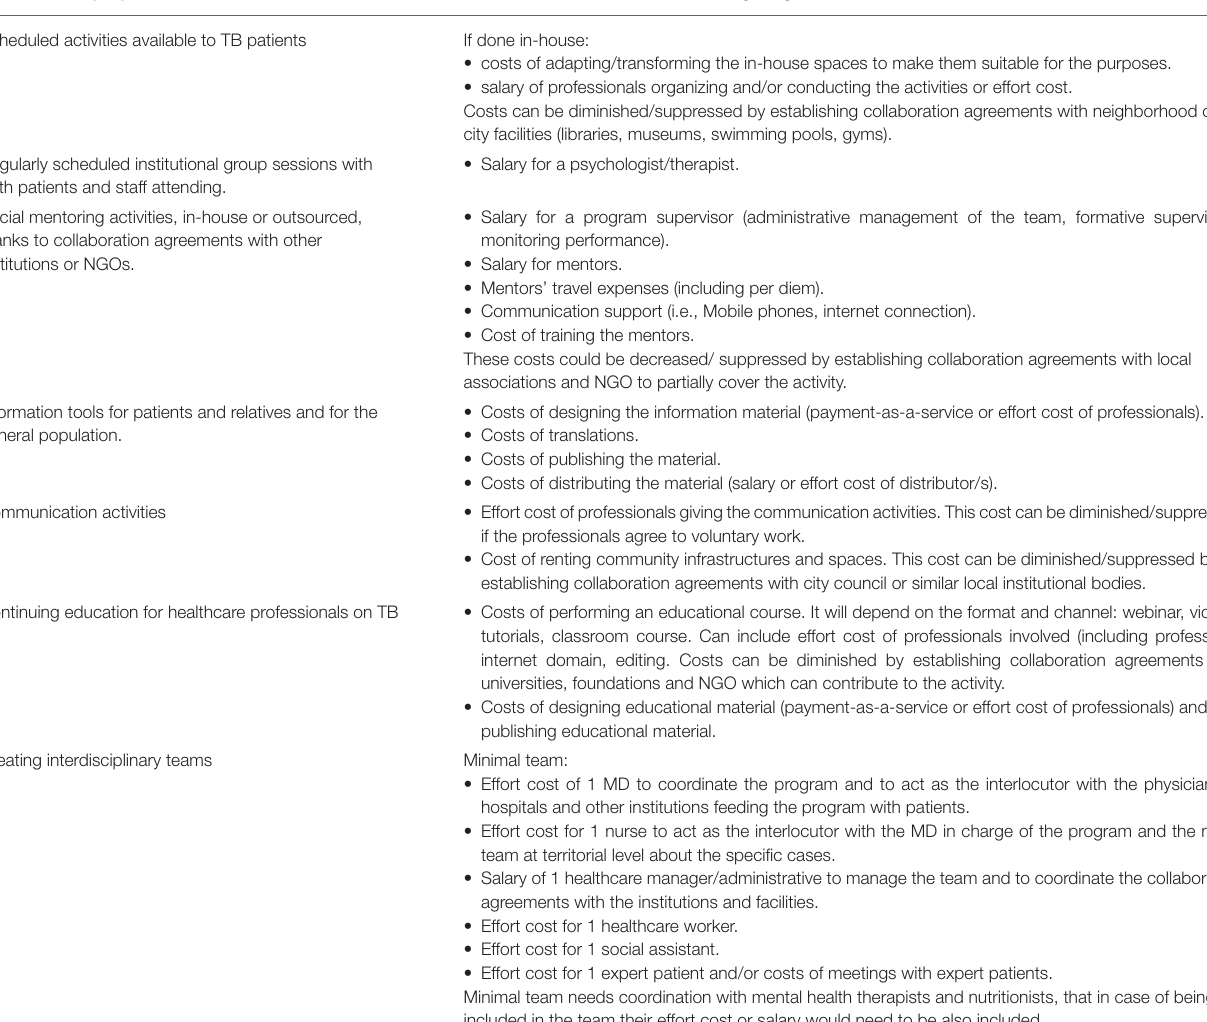
TABLE 2 | Suggested items to be considered when budgeting the specific interventions